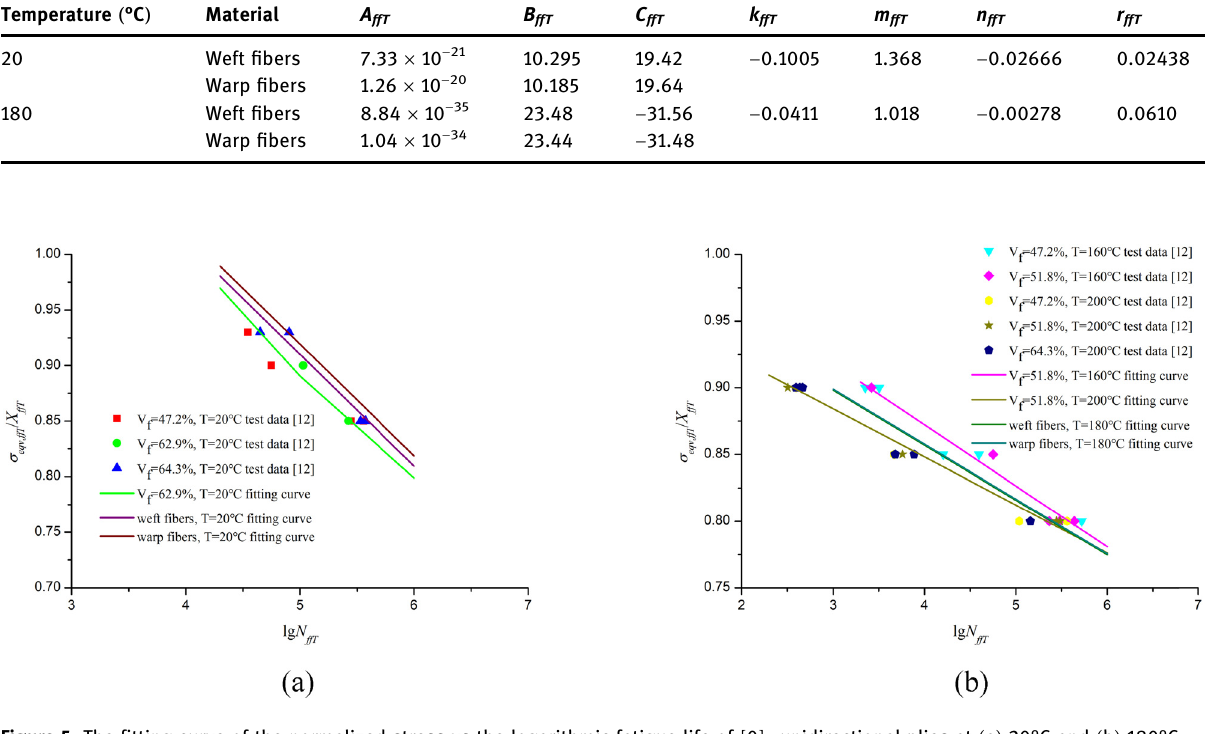
Figure 5: The fi tting curve of the normalized stress vs the logarithmic fatigue life of [ 0 ] n unidirectional plies at ( a ) 20°C and ( b ) 180°C.